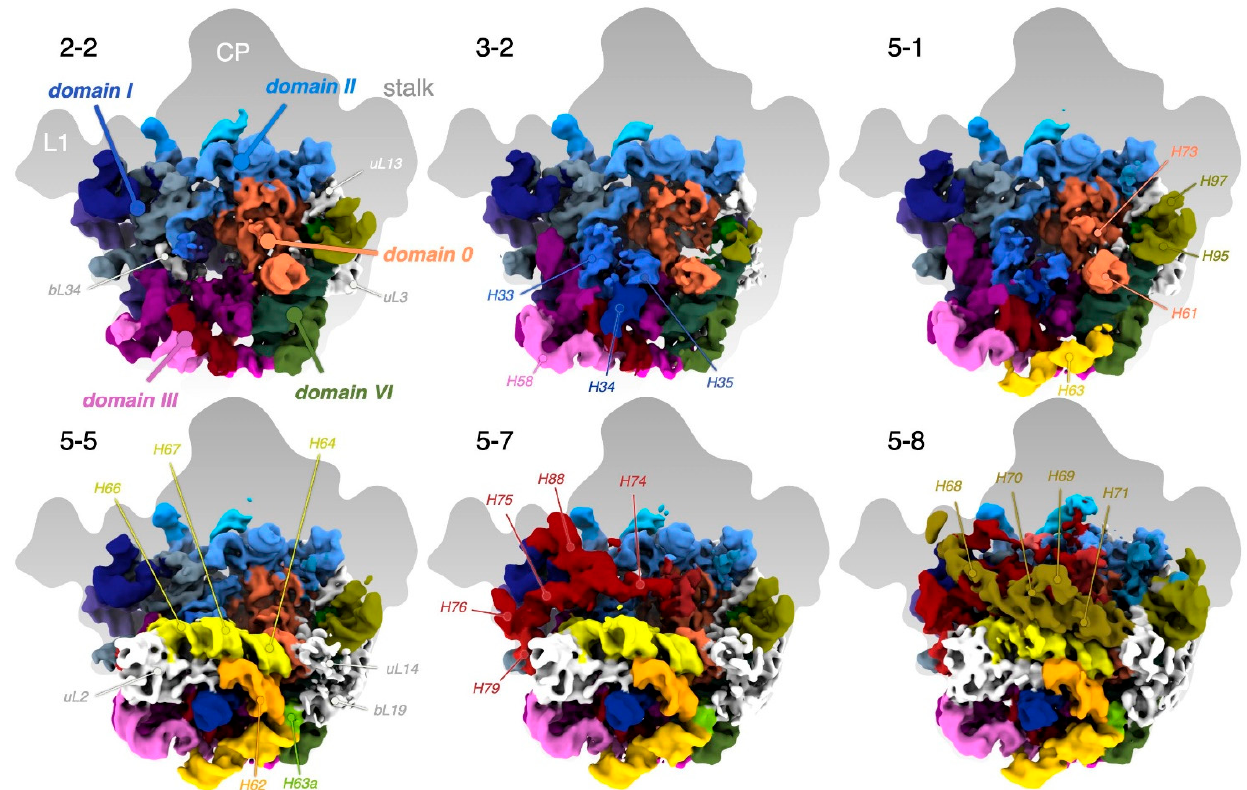
Figure 7. Side-by-side comparisons of particles of different sizes. RNA is colored as in Figure 2b and proteins are shown in white.